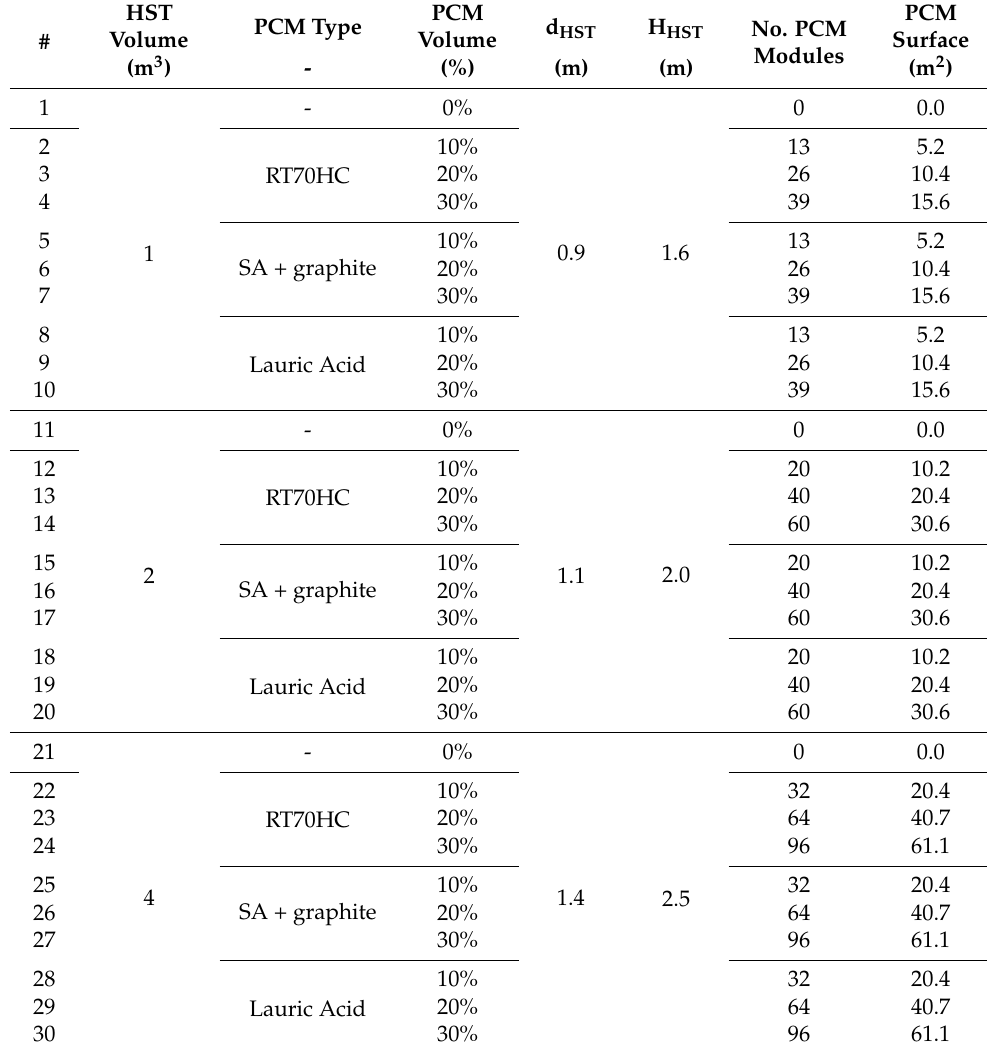
Table 2. Full factorial design of experiments matrix to evaluate the effect of HST volume, PCM type and PCM volume fraction on the solar share for the winery demo site.